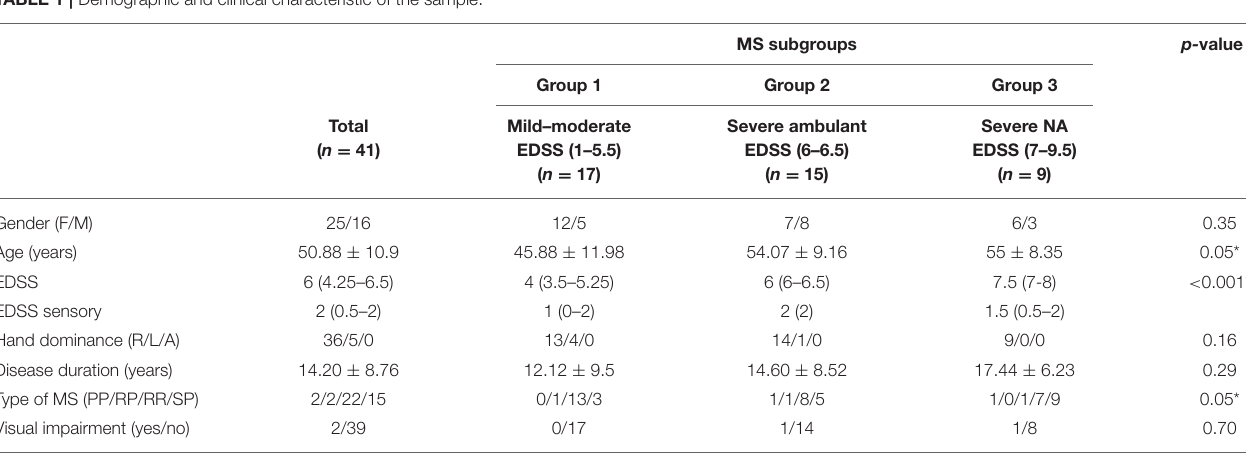
TABLE 1 | Demographic and clinical characteristic of the